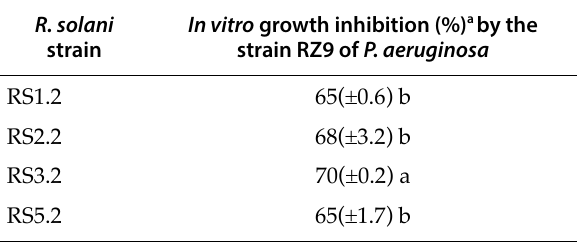
Table 1. Antibiosis of the strain RZ9 of Pseudomonas aerugi- nosa against four Rhizoctonia solani strains isolated from field infected potato tubers collected from the north, the centre, and the south of Tunisia. Growth inhibition (%) = (A-B)/A) x 100; where: A; diameter of mycelia growth in control growth, B; diameter of mycelia growth in antibiosis